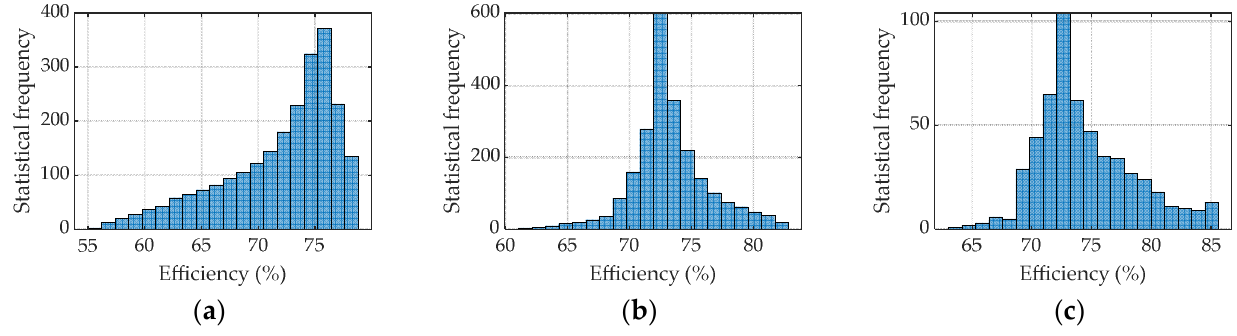
Figure 14. Efficiency models of two motors in full working conditions. ( a ) 8 kW motor; ( b ) 5 kW motor.